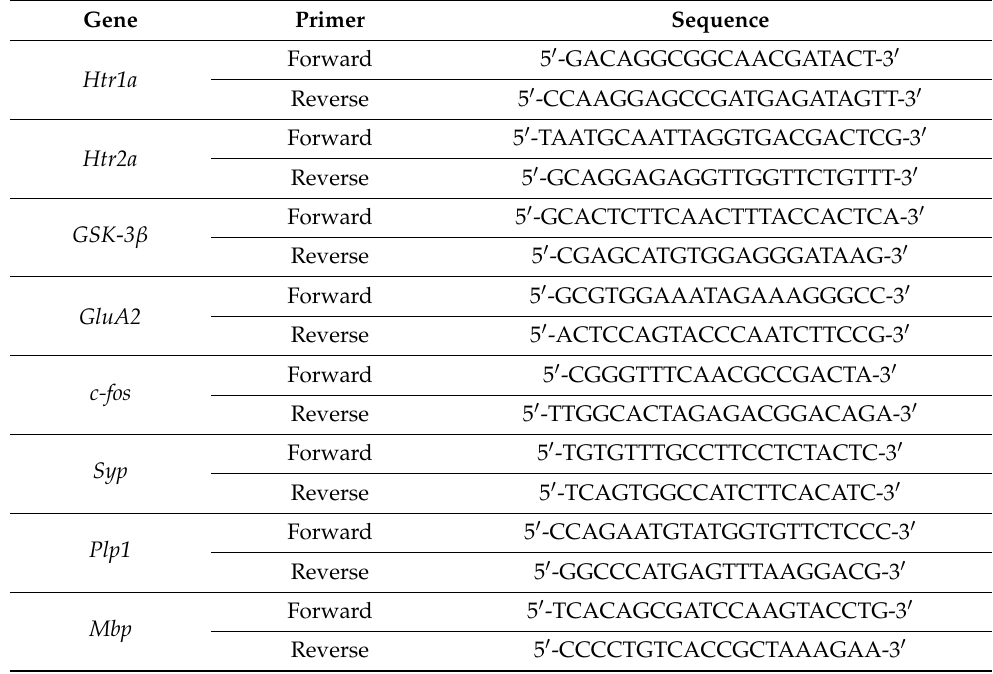
Table A1. Primer sequences for mRNA expression